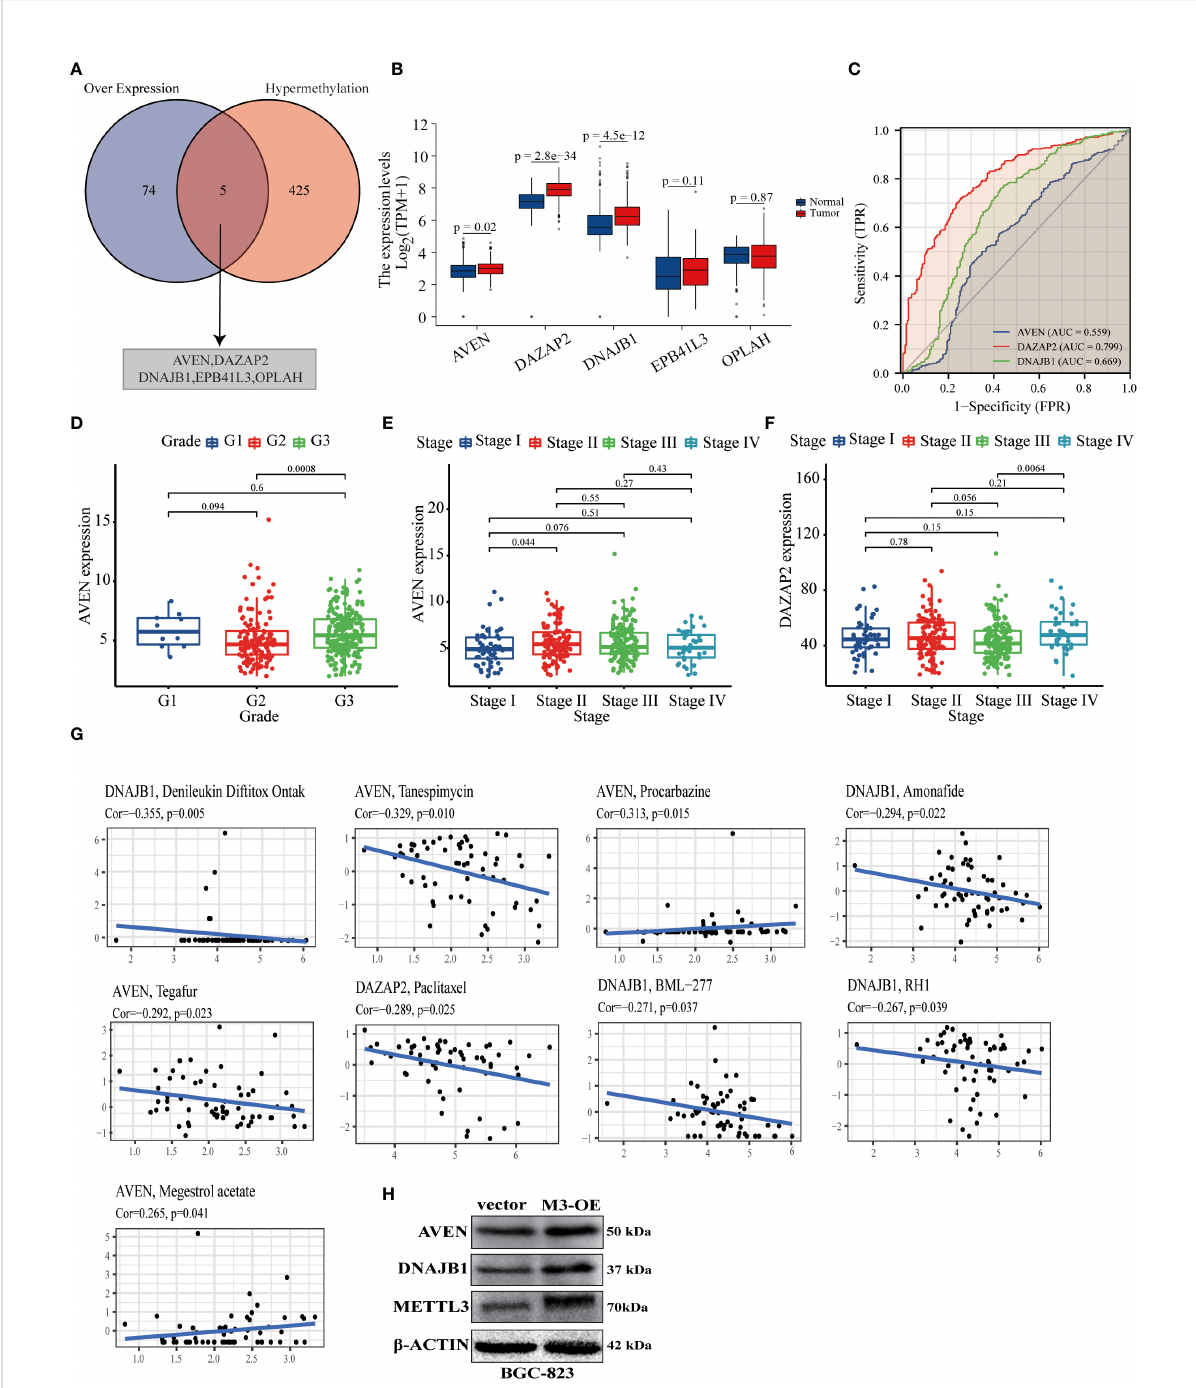
FIGURE 6 METTL3-mediated gene expression was associated with poor clinical prognosis and treatment of GC patients. (A) Venn diagram of the intersection of up-regulated DEPs and DMGs by proteomic and m6A epitranscriptomic microarray analysis; the intersected genes were AVEN, DAZAP2, DNAJB1, EPB41L3, OPLAH. (B) Differential expression of fi ve intersecting molecules in GC and normal gastric mucosal tissue. (C) ROC curves of AVEN, DAZAP2 and DNAJB1 used to predict 5- year survival in GC based on datasets from the TCGA and GEO databases. (D – F) The expression levels of AVEN and DAZAP2 were correlated with the clinicopathological grade and stage of GC patients. (G) The expression levels of AVEN, DAZAP2 and DNAJB1 in GC were correlated with antitumor drugs, with and Cor representing the correlation coef fi cient. (H) The expression levels of AVEN and DNAJB1 were signi fi cantly upregulated by METTL3 overexpression in BGC-823